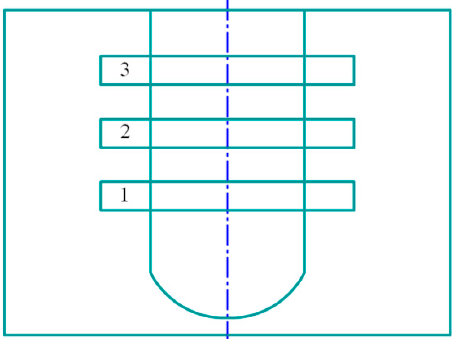
Figure 7. Scheme of cutting templates from a welded joint for studying the structure, mechanical and crack resistance properties and determining the microhardness (1–3 template numbers). crack resistance properties and determining the microhardness (1–3 template